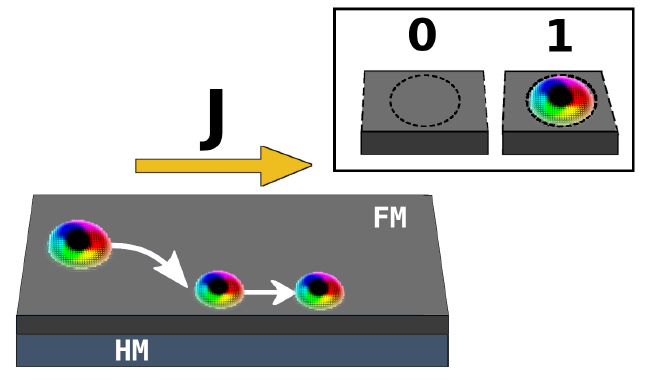
Figure 1. Skyrmion movement inside a plain nanostrip in response to a current flow. In the inset, the encoding of binary information with